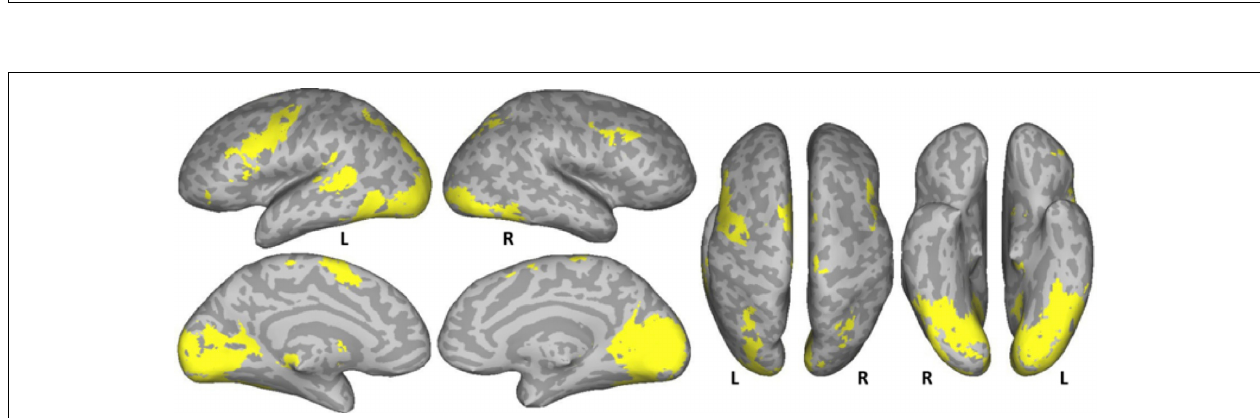
FIGURE 2 | Conjunction results for the normal text (NT), pseudowords (PW), and consonant string (CS) conditions (NT – fixation n PW − fixation n CS − fixation). L, Left Hemisphere; R, Right Hemisphere.